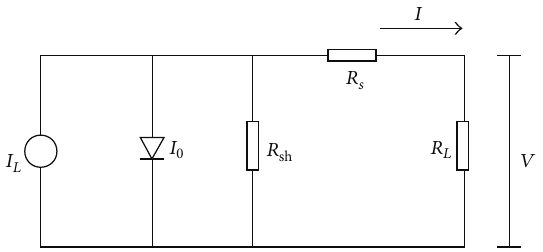
Figure 1: One diode simplified equivalent circuit for a solar cell closed on a resistive load 𝑅 𝐿 .